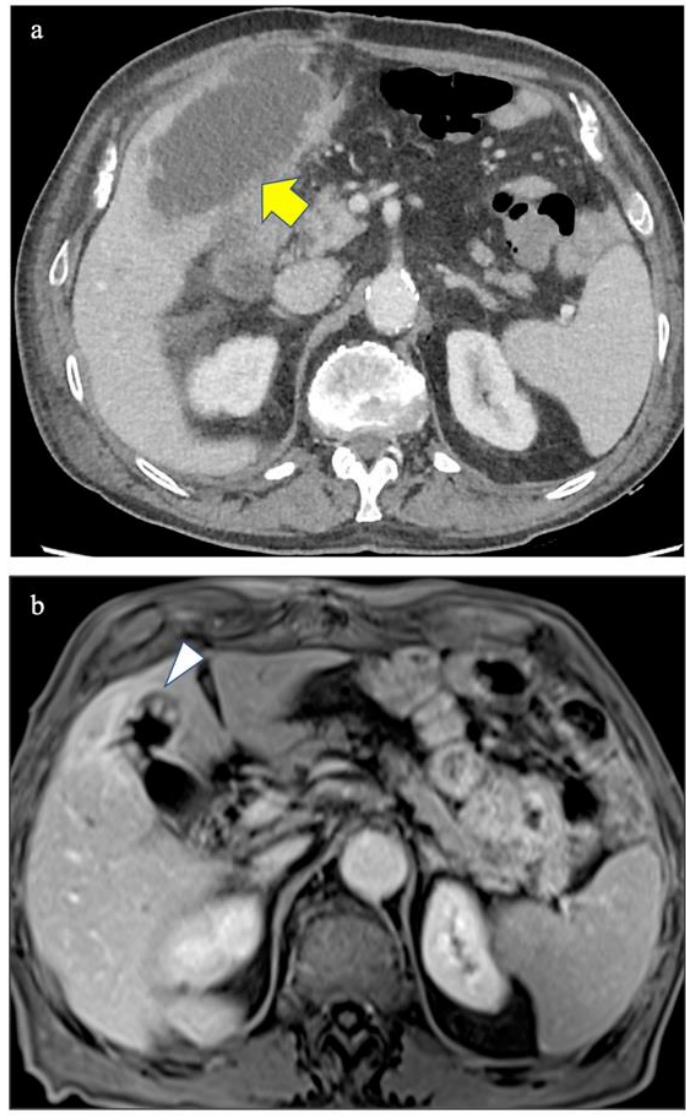
Figure 1. Axial contrast-enhanced Computed Tomography image of the upper abdomen well- demonstrating the acute cholecystitis with localized perforation (yellow arrow in ( a )) and fat-saturated Volume Interpolated Breath-Hold Examination (VIBE) Magnetic Resonance image after contrast injection performed 90 days later showing multiple small pseudopolyps in the fundus of the gallbladder (white arrow in ( b )).